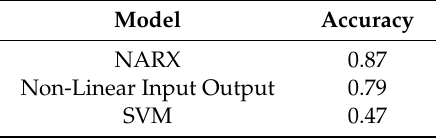
Table 3. Comparison of accuracy of NARX with Non-Linear Input Output and Support Vector Machines (SVM).